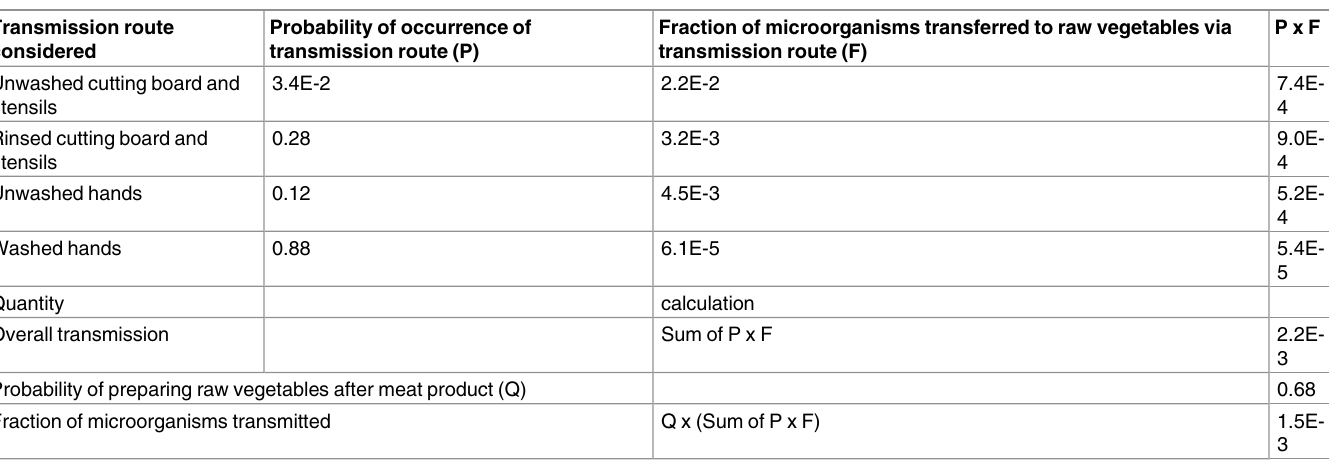
Table 5. Calculation of the extent of